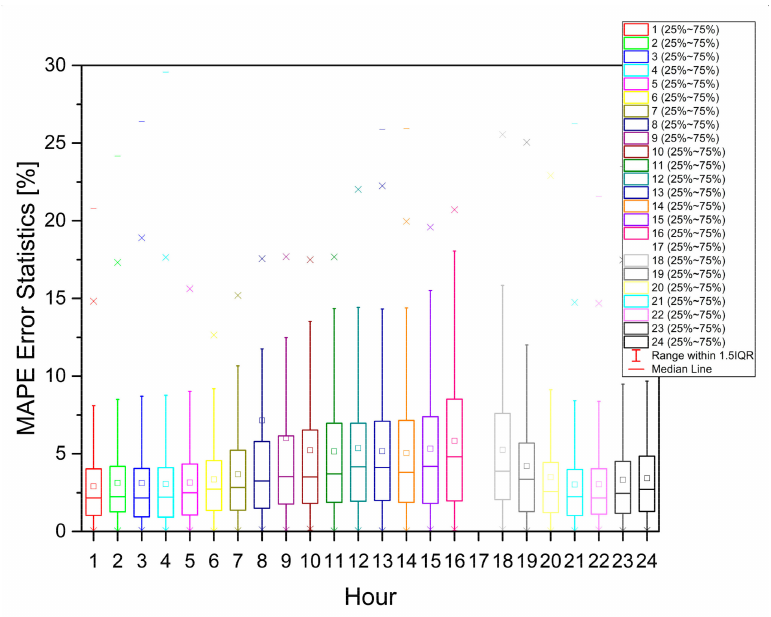
Figure 14. FF-ANN forecasting: Box-plot of the error distribution of forecasted load as function of the hour of day for 2022.